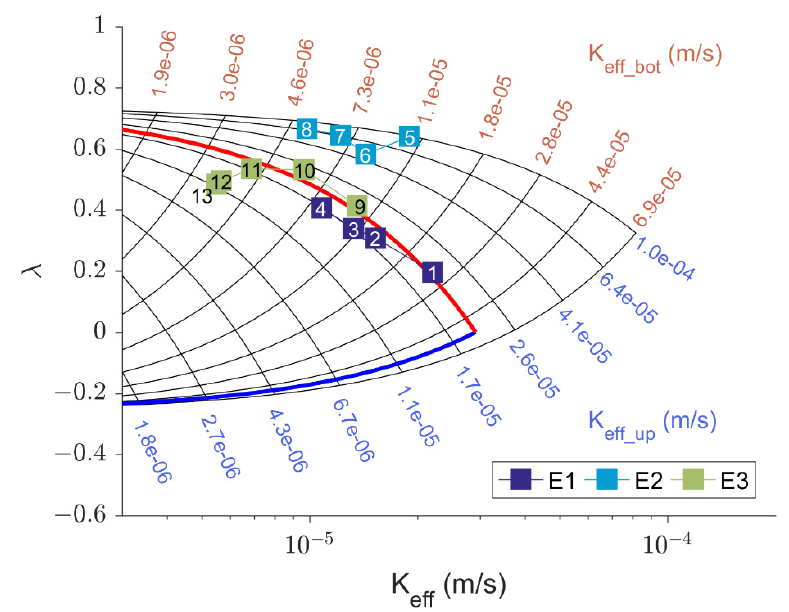
Figure 8. Experimental results in the λ - K ef f diagram. The number in each square presents the experiment sequence number in Table